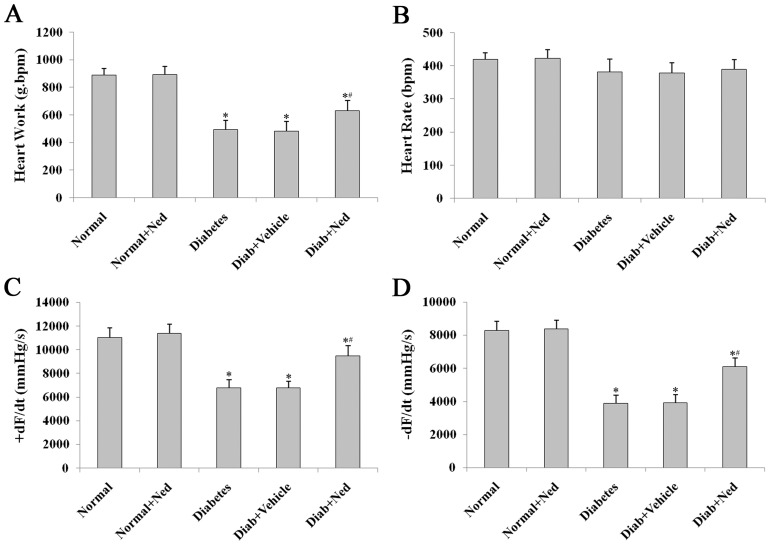
Cardiac function of isolated and perfused hearts from normal and STZ-induced diabetic mice after nedocromil (Ned) treatments.Contractile function of the heart was determined using a multi-channel physiological recorder. Changes in heart work (A), heart rate (B), maximal rate of contraction (C), and relaxation (D) are presented. Quantitative data are shown as means ± SD (n = 15 per group). *P<0.05 vs. untreated normal group; #P<0.05 vs. untreated diabetic group.